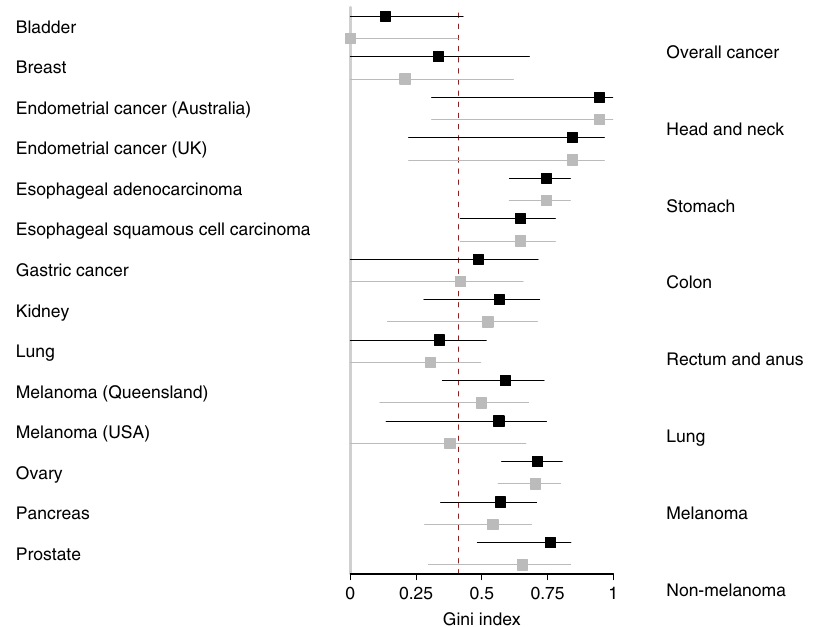
Fig. 4 Gini indices derived from array heritability estimates. Gini indices with 95% con fi dence intervals are calculated from array heritability estimates derived from Lu et al. 29 The black boxes are based on array heritability removing loci with known association with the cancers. The red dashed line marks the Gini index of income in the USA